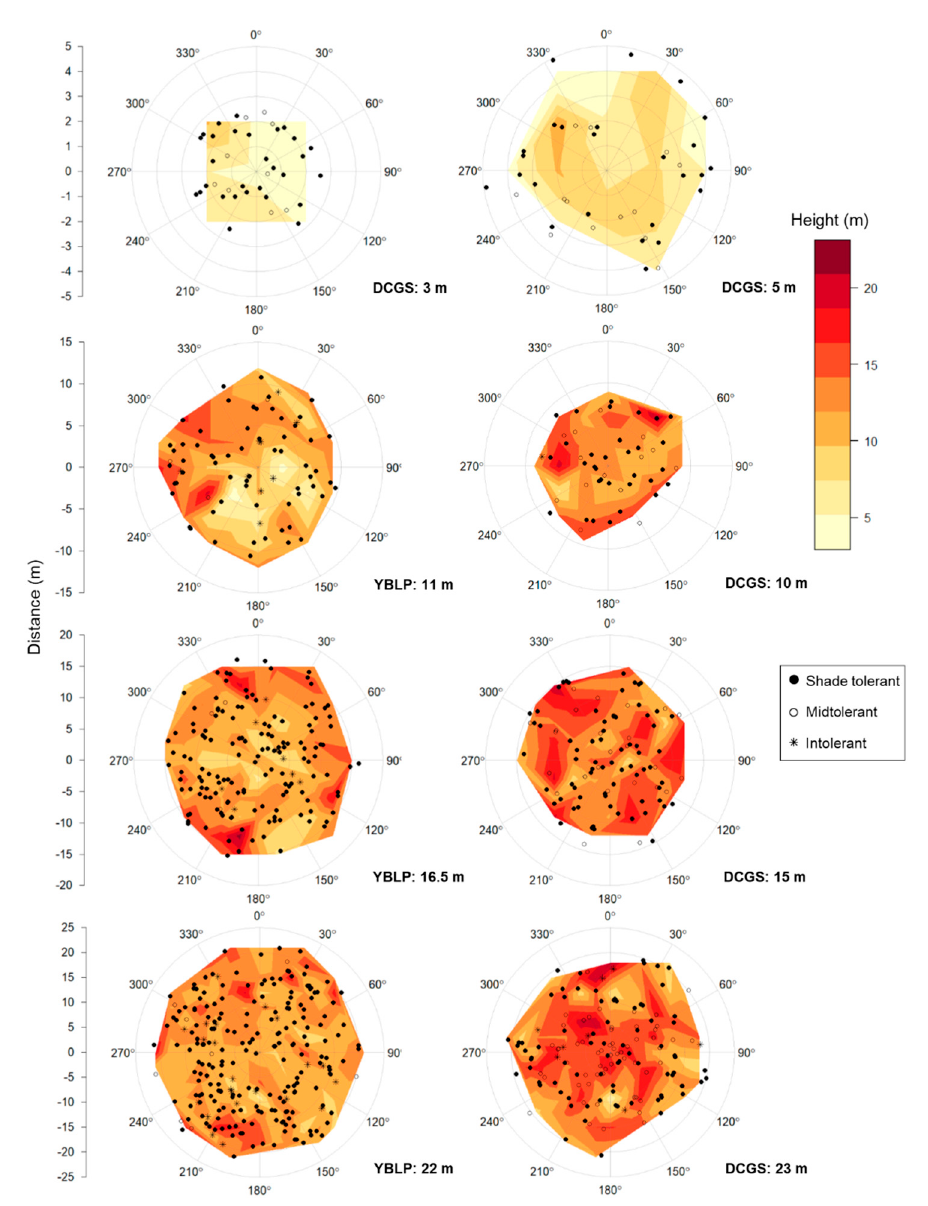
Figure 4. Locations of individual gap-capturing saplings and height-averaged contour maps for experimental group-selection openings of varying sizes at two study sites in northern hardwoods of the upper Great Lakes, USA. Each plot represents data from individual opening-size class-based harvest radii: In the DCGS, 3 m ( n = 12), 5 m ( n = 12), 10 m ( n = 12), 15 m ( n = 12), and 23 m ( n = 15); in the YBLP, 11 m ( n = 16), 16.5 m ( n = 17), and 22 m ( n = 16). Sapling heights were averaged within 3 × 3 m bins, and contours were created by linearly interpolating averaged heights between bin center points. Dots denote individual saplings, and shapes denote shade-tolerance classes. Centers of plots correspond to centers of canopy openings, and degrees refer to directional azimuths. Openings were roughly circular, and the angular shapes of the contour plots are artifacts of the interpolation process. Note the y-axis scales are not uniform.